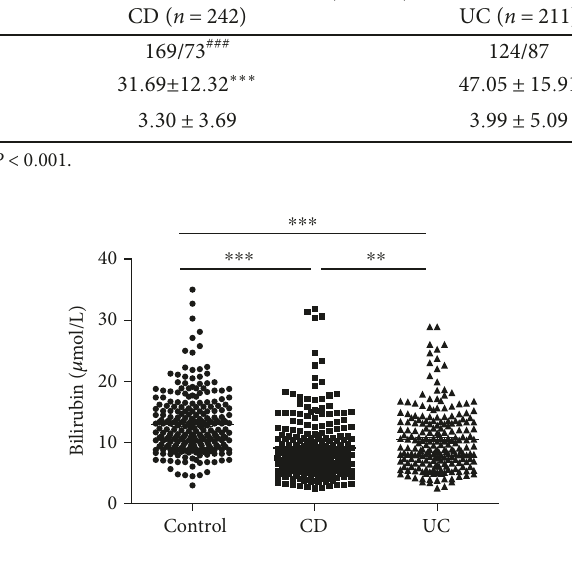
Figure 1: Serum bilirubin levels in CD patients ( n = 242 ), UC patients ( n = 211 ), and healthy controls ( n = 255 ). ∗∗ P < 0 01 ; ∗∗∗ P < 0 001